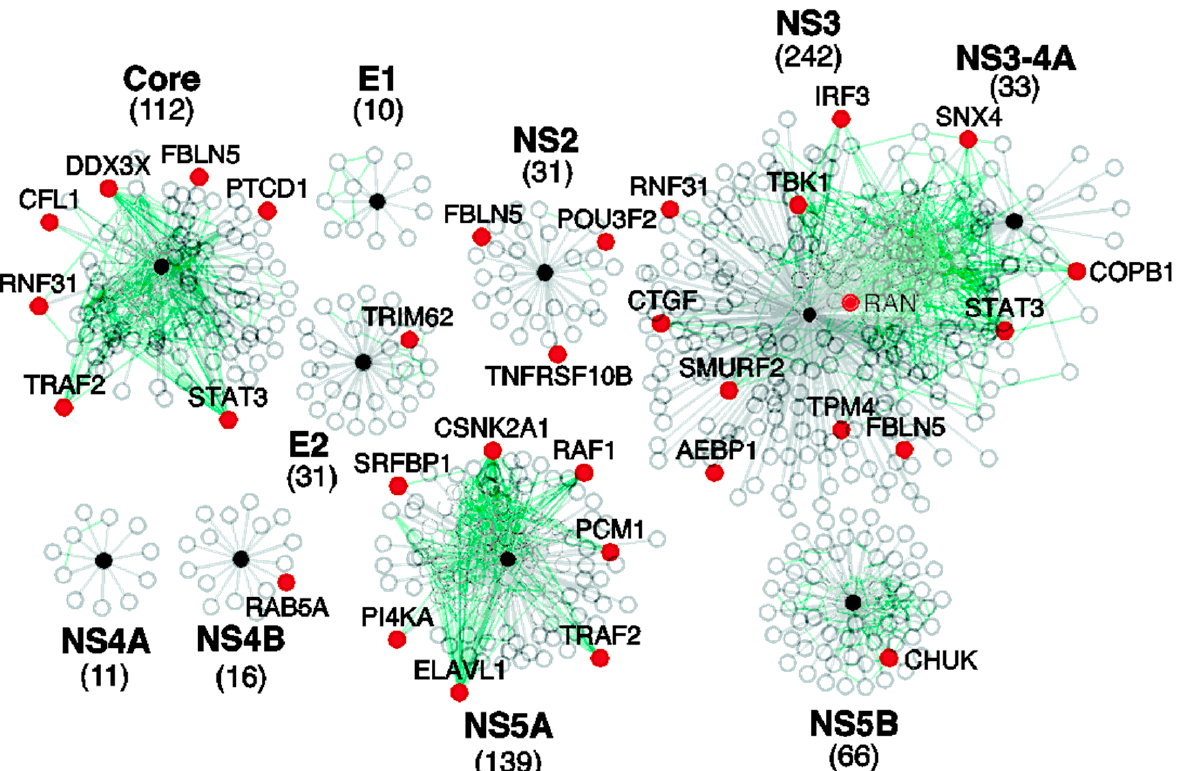
Figure 1. The interactions between HCV and cellular proteins. HCV-human protein–protein interactions (grey lines) were downloaded from the HCVPro database [54] and deduced from references [55,56] . The black spheres represent HCV proteins, the white spheres indicate cellular proteins that bind to HCV proteins, and the red spheres signify human proteins that bind to HCV proteins and were implicated in HCV replication by at least one large-scale siRNA screen. The green lines represent interactions between cellular proteins that bind to HCV proteins. The total number of cellular proteins that bind to each HCV protein is shown in parentheses beneath the protein name. Reproduced from [41] with permission from the Royal Society of Chemistry.